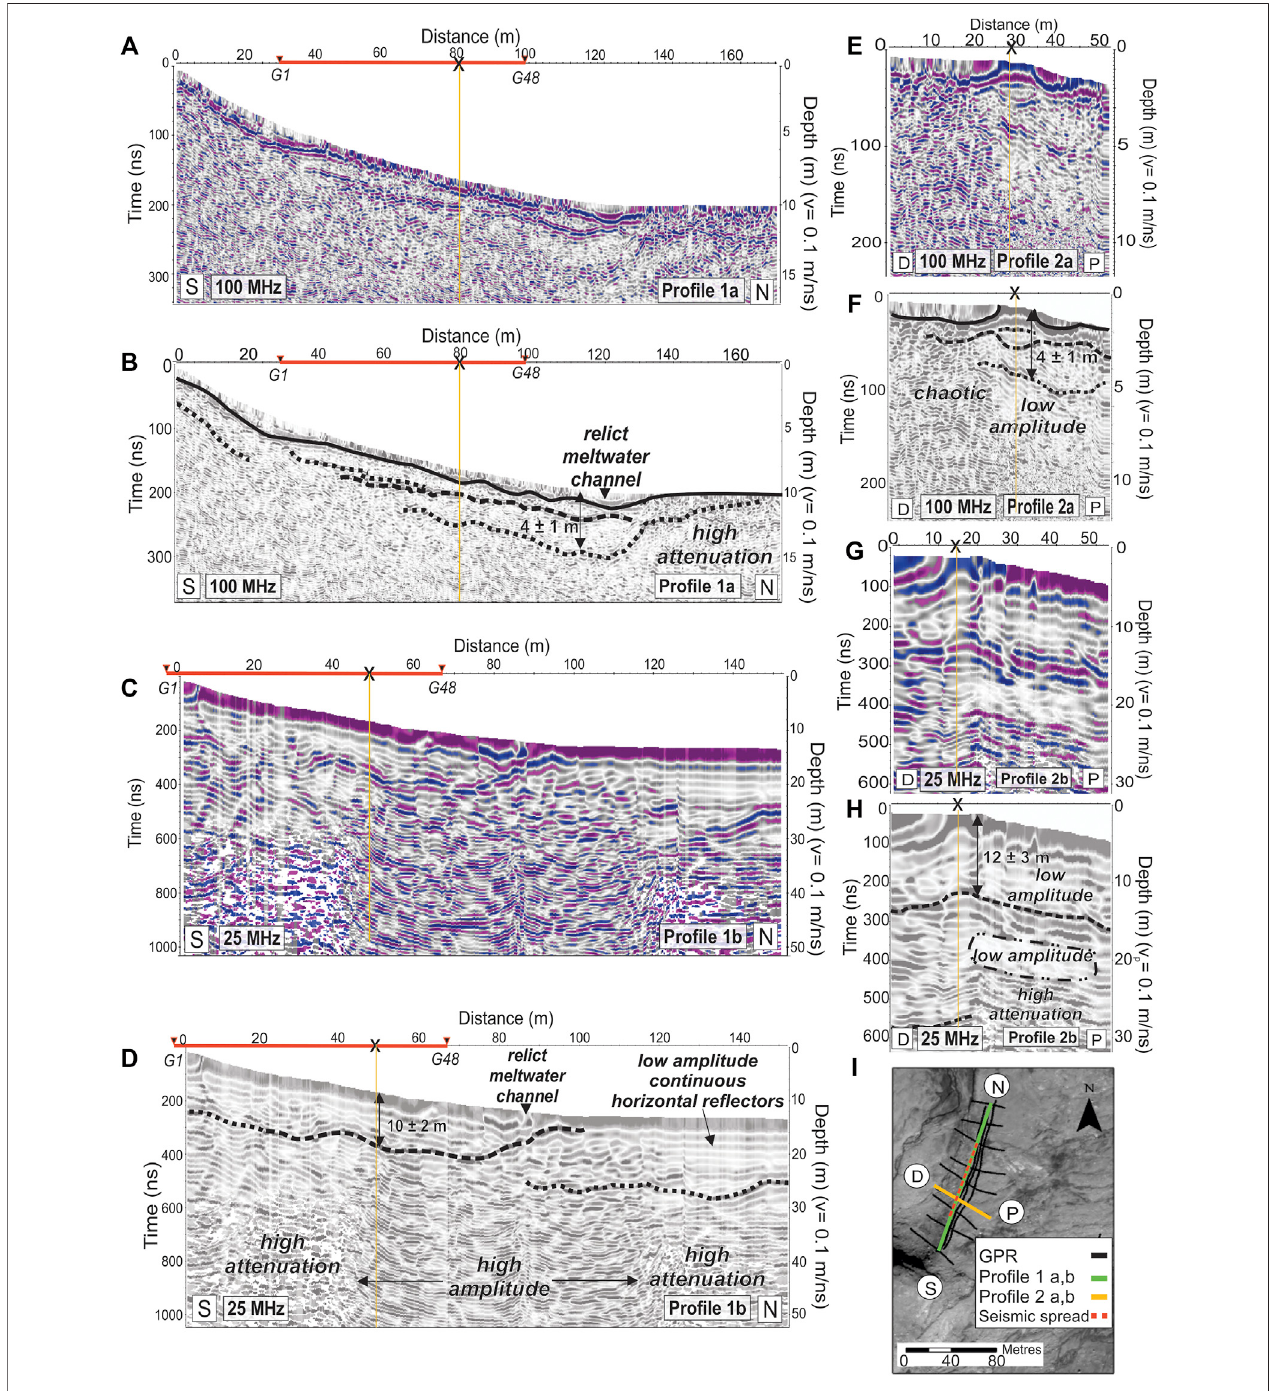
FIGURE 3 | Processed GPR data from the Lateral Moraine Site. (A) Pro fi le 1a: 100 MHz longitudinal pro fi le at the crest of the moraine and (B) interpretation. (C) Pro fi le 1b: 25 MHz longitudinal pro fi le parallel to moraine crest and (D) interpretation. (E) Pro fi le 2a: 100 MHz cross-sectional pro fi le over the moraine and (F) interpretation. (G) Pro fi le2b: 25 MHzcrosssectionalpro fi leoverthemoraineand (H) interpretation. (I) SatelliteimagewithdiagramofapproximateGPRpro fi lelocations at the Lateral Moraine Site. N, S, P, and D indicate North, South, ice proximal, and ice distal, respectively. In B, D, F & H, solid lines indicate the snow-ground interface. Dashed lines mark continuous re fl ections, dotted lines delineate discontinuous re fl ections, and dot-dashed lines de fi ne changes in radargram character. G1 andG48indicatetheapproximatelocationsofseismicgeophones1and48.XandyellowlinesindicatetheapproximatecrossoverlocationofPro fi les1and2oneachof the